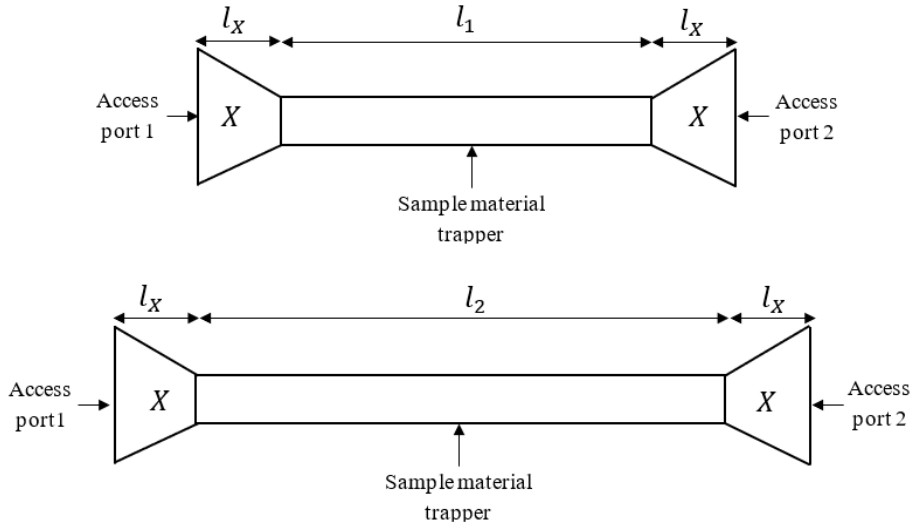
Figure 1. Two identical transmission-line configurations differentiated by length.